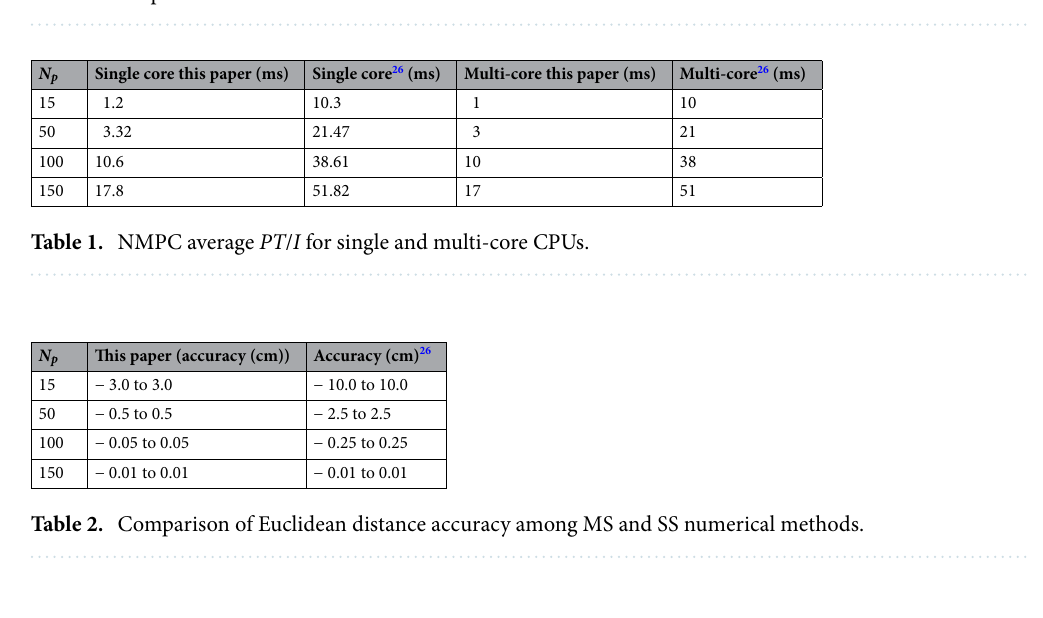
Figure 6. ( a ) Box plot to distinguish the actual state tracking errors; where pose (x,y) are in c m and heading is in rad . Additionally, Ox e , Oy e and O θ e represents obstacles case. ( b ) Applied voltages to the UGV in the simulation experiment 3.